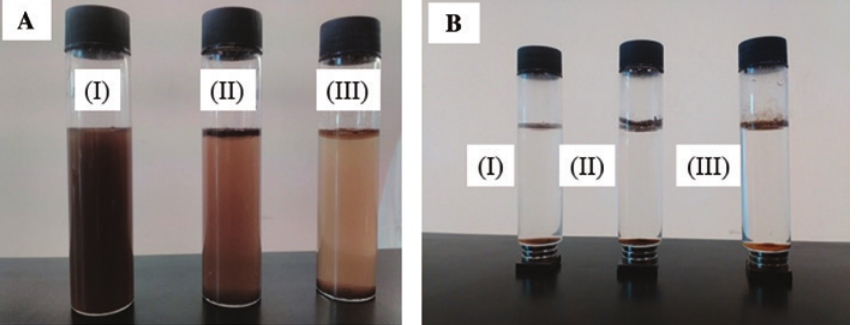
O @SiO -Ph prepared using (I) 5%, (II) 12.5% and (III) 50% of PTES in TEOS. 3 4 2